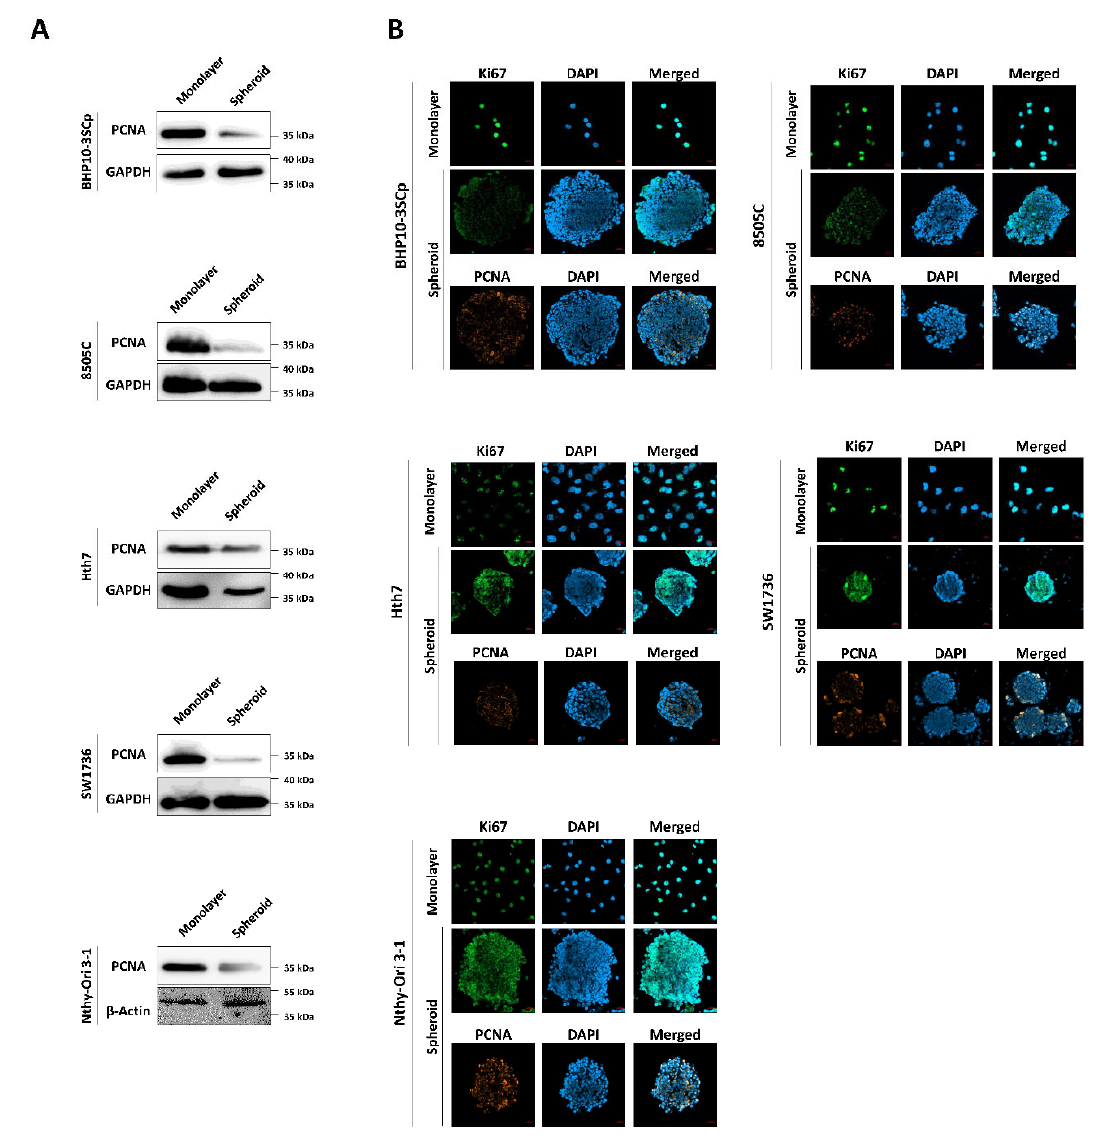
Figure 4. Immunofluorescence and Western blot analysis with cell proliferation markers. ( A ) Western blot analysis showing expression of PCNA, as a cell proliferation marker. GAPDH and β -Actin were used as loading control. ( B ) Representative immunofluorescence images showing cell proliferation with proliferating cell nuclear antigen (PCNA), Ki67. Scale bar: 50 μ m.